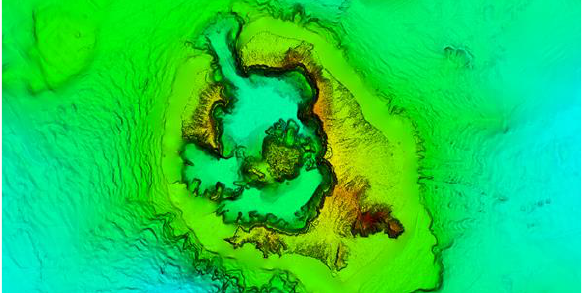
Figure 17. LODS creation. (left to right) 1 st row : initial textured model with four LODs; 2 nd row : normal map generation for Figure 15. Final 2.5D DEM. each model; 3 rd row : Initial model to final simplified model.